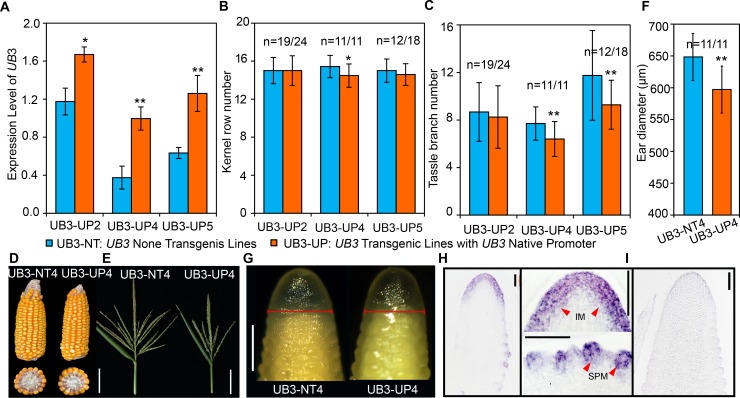
Inflorescence architecture of UB3 transgenic lines.(A) Expression levels of UB3 in 2–3 mm ears of the three independent transgenic lines and non-transgenic lines, three biological replicates. UB3-UP: UB3 transgenic lines containing constructs driven by UB3 native promoter: UB3-UP2, UB3-UP4, UB3-UP5. UB3-NT: UB3 nontransgenic lines: UB3-NT2, UB3-NT4, UB3-NT5. Values are shown as the mean ± s.e. *, p<0.05; **, p<0.01. (B, C) Phenotypes of inflorescence traits including kernel row number (B), and the tassel branch number (TBN, C) in the UB3 transgenic and nontransgenic lines. (D-E) Architecture of inflorescences in UB3-NT4 and UB3-UP4. Bar = 6 cm. (F, G) Inflorescence meristems (F) and diameters (G) of 2–3 mm ears in UB3-NT4 (n = 9) and UB3-UP4 (n = 11). Bar = 500 μm in (G). (H, I) mRNA in situ hybridization of UB3 in the inflorescence meristem and spikelet pair meristems (H) using anti-sense probes. The arrow refers to the signal region. UB3 sense probes as negative controls (I), bar = 100 μm. In (B, C, F) values are shown as the mean ± s.d; n, number of individual ears. The significant differences were estimated using the one-way ANOVA. *, p<0.05; **, p<0.01.